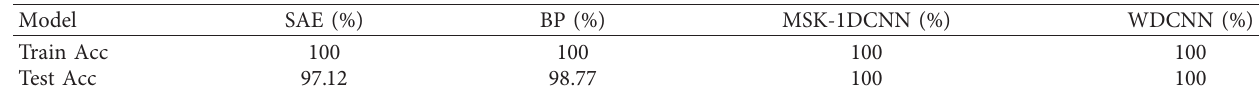
Table 3: Diagnosis accuracy of each model on the no-noise dataset.